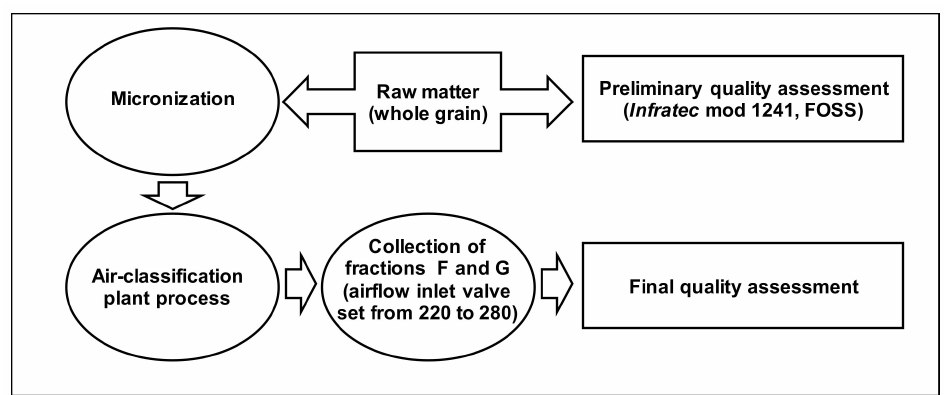
Figure 1. Flow chart of the experimental plan.